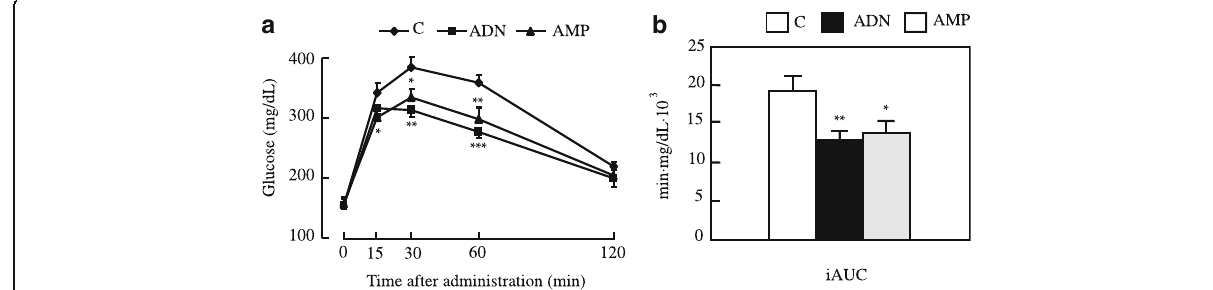
Fig. 3 Oral glucose tolerance tests of mice with high-fat diet-induced obesity administered ADN or AMP. a Blood glucose changes; ( b ) incremental areas under the curve (iAUC). Values are means ± SEM, n = 5 or 6. *p < 0.05, ** p < 0.01, *** p < 0.001 versus the control group. C, control group; ADN, adenosine group; AMP, adenosine-5 ′ -monophosphate group